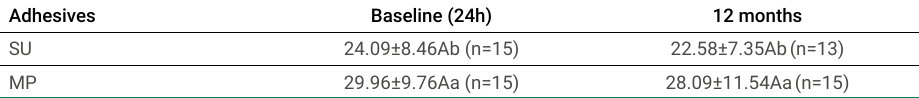
Table 2. Means and standard deviations of tested groups (MPa).